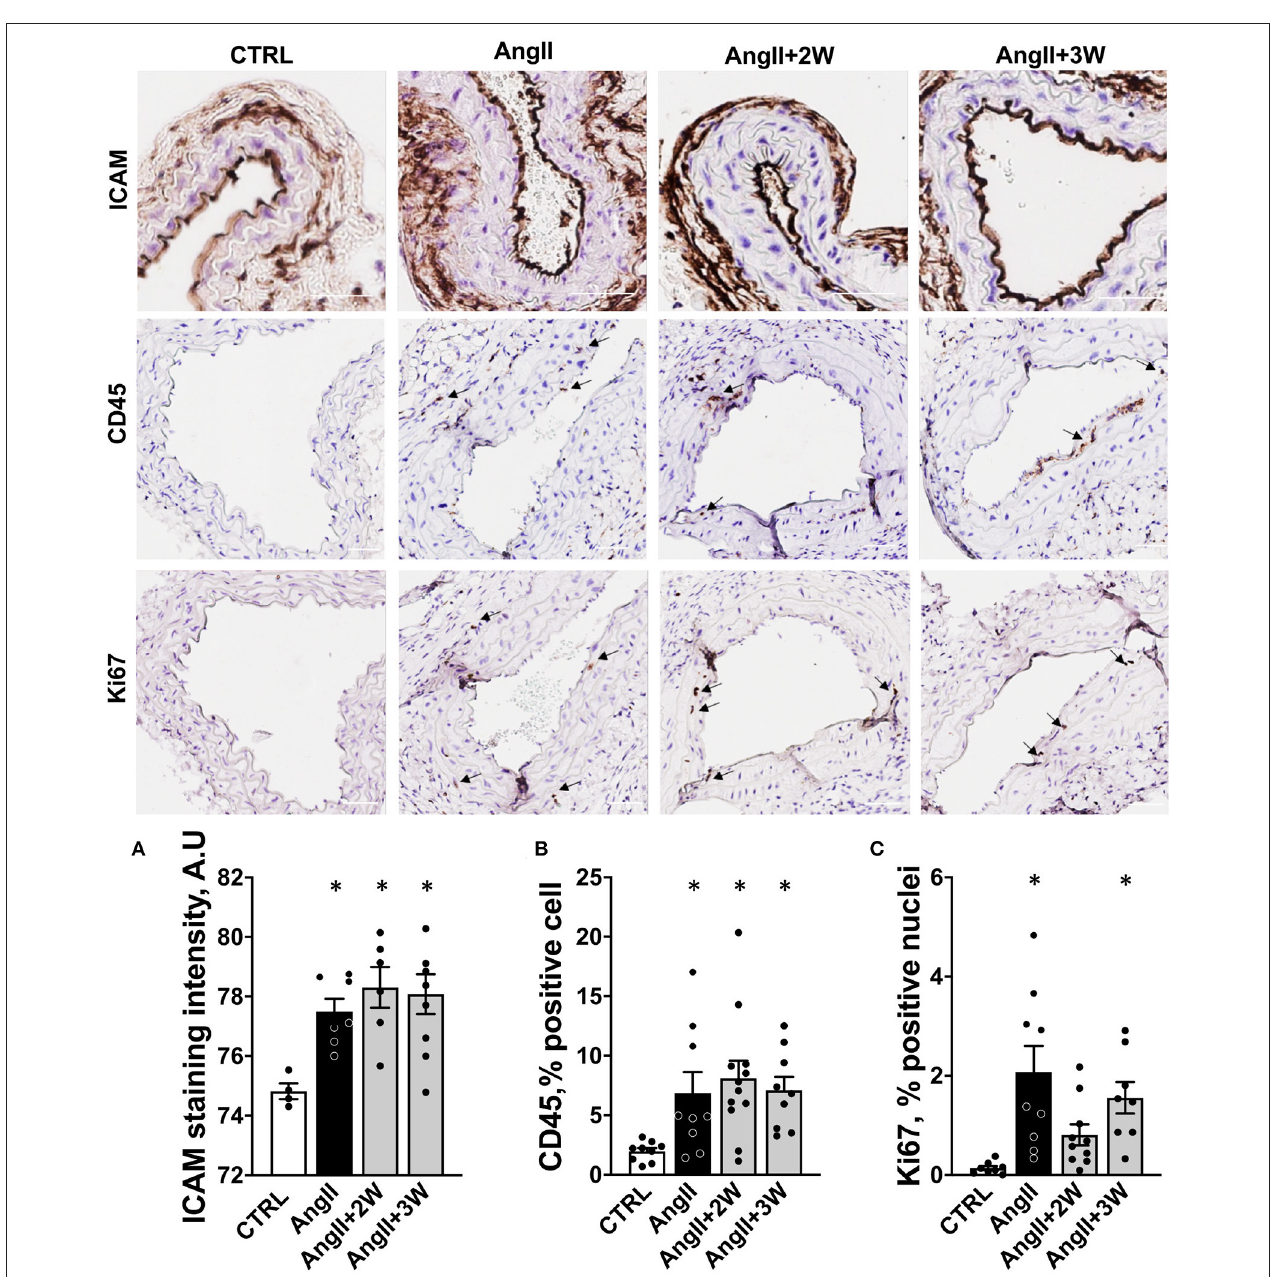
FIGURE 2 | Memory effect on vascular endothelial activation, cell proliferation, and inflammation. (A) Quantification of endothelial staining for ICAM-1 in paraffin embedded sections of carotid arteries, expressed in arbitrary units of staining intensity, n = 26. (B) Quantification of staining for CD45 in paraffin embedded sections of aortas, expressed as % of stained cell. (C) Quantification of staining for Ki67 in paraffin-embedded sections of aortas, expressed as % of stained cells. * p < 0.05; n = 39 (B,C) ; One-way ANOVA followed by Dunett’s multiple comparisons test. Arrows indicate specific staining for CD45 and Ki67, scale bar = 100 µ m.